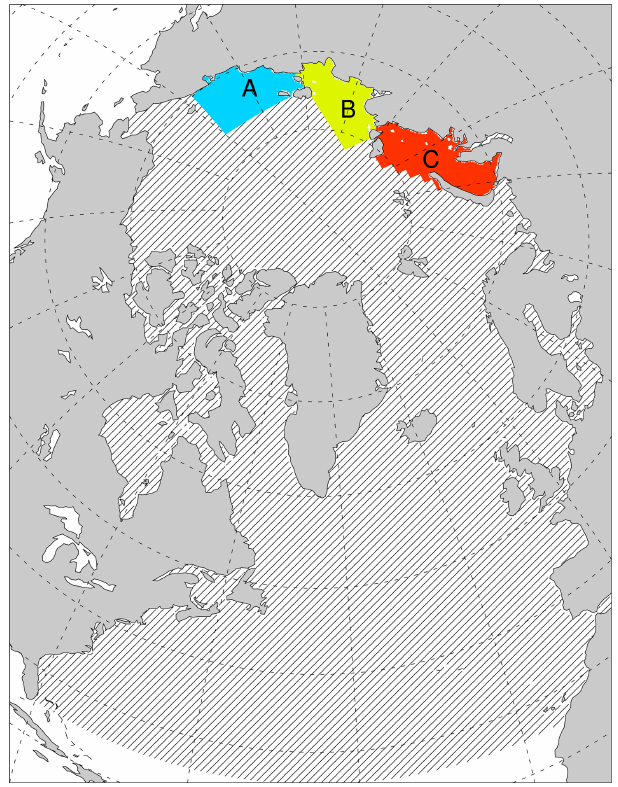
Figure 4. Computational domain shown in slanted black lines along with the three regions for which total landfast area is calculated (“A” for East Siberian Sea, “B” for Laptev Sea and “C” for Kara Sea). Taken from Fig. 2 of Lemieux et al. (2016), ©Crown copyright 2016.